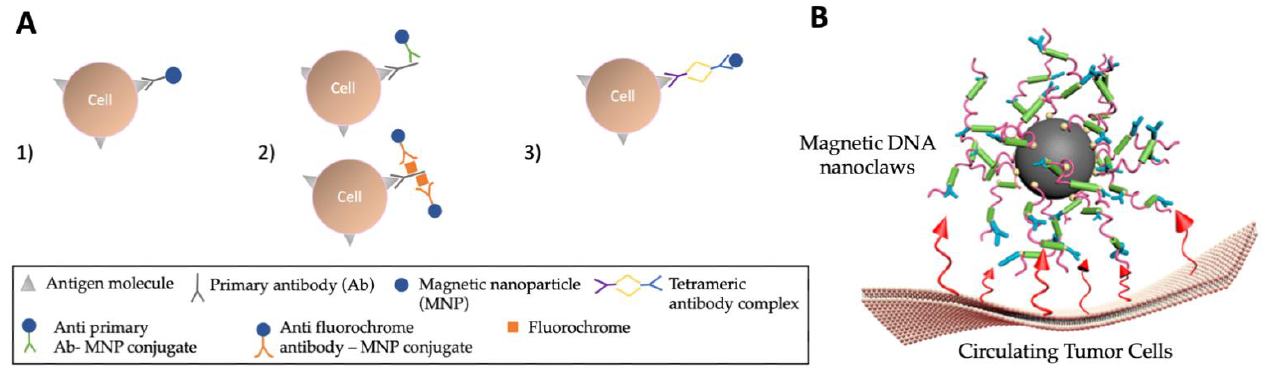
Figure 3. Different labeling strategies based on antibodies. ( A ) ( 1 ) Direct labeling strategy. ( 2 ) Indirect labeling. ( 3 ) Use of a tetrameric antibody complex, presenting two different affinities, one for the target molecule on the cell and one for the magnetic particle. ( B ) Illustration of multivalent binding strategy. Adapted with permission from [89]. Copyright 2019, American Chemical Society. cells should be labeled with antibodies for subsequent positive selection (i.e., the labeled